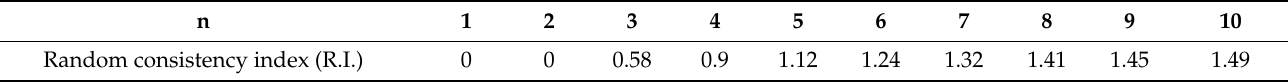
Table 2. Random consistency index by Saaty